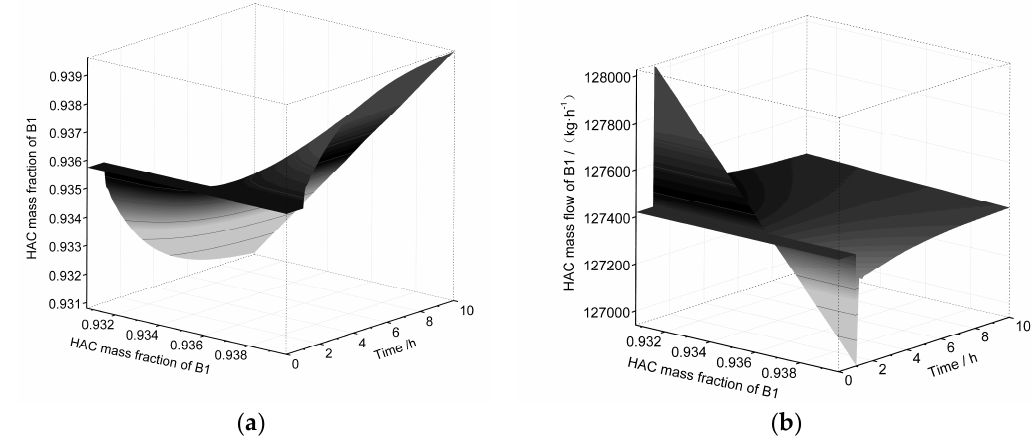
Figure 8. Sensitivity analysis of the HAc concentration in the bottom of the column after adding temperature and component controllers. ( a ) Sensitivity analysis of the HAc concentration at the bottom of the column. ( b ) Sensitivity analysis of the HAc mass flow at the bottom of the column.